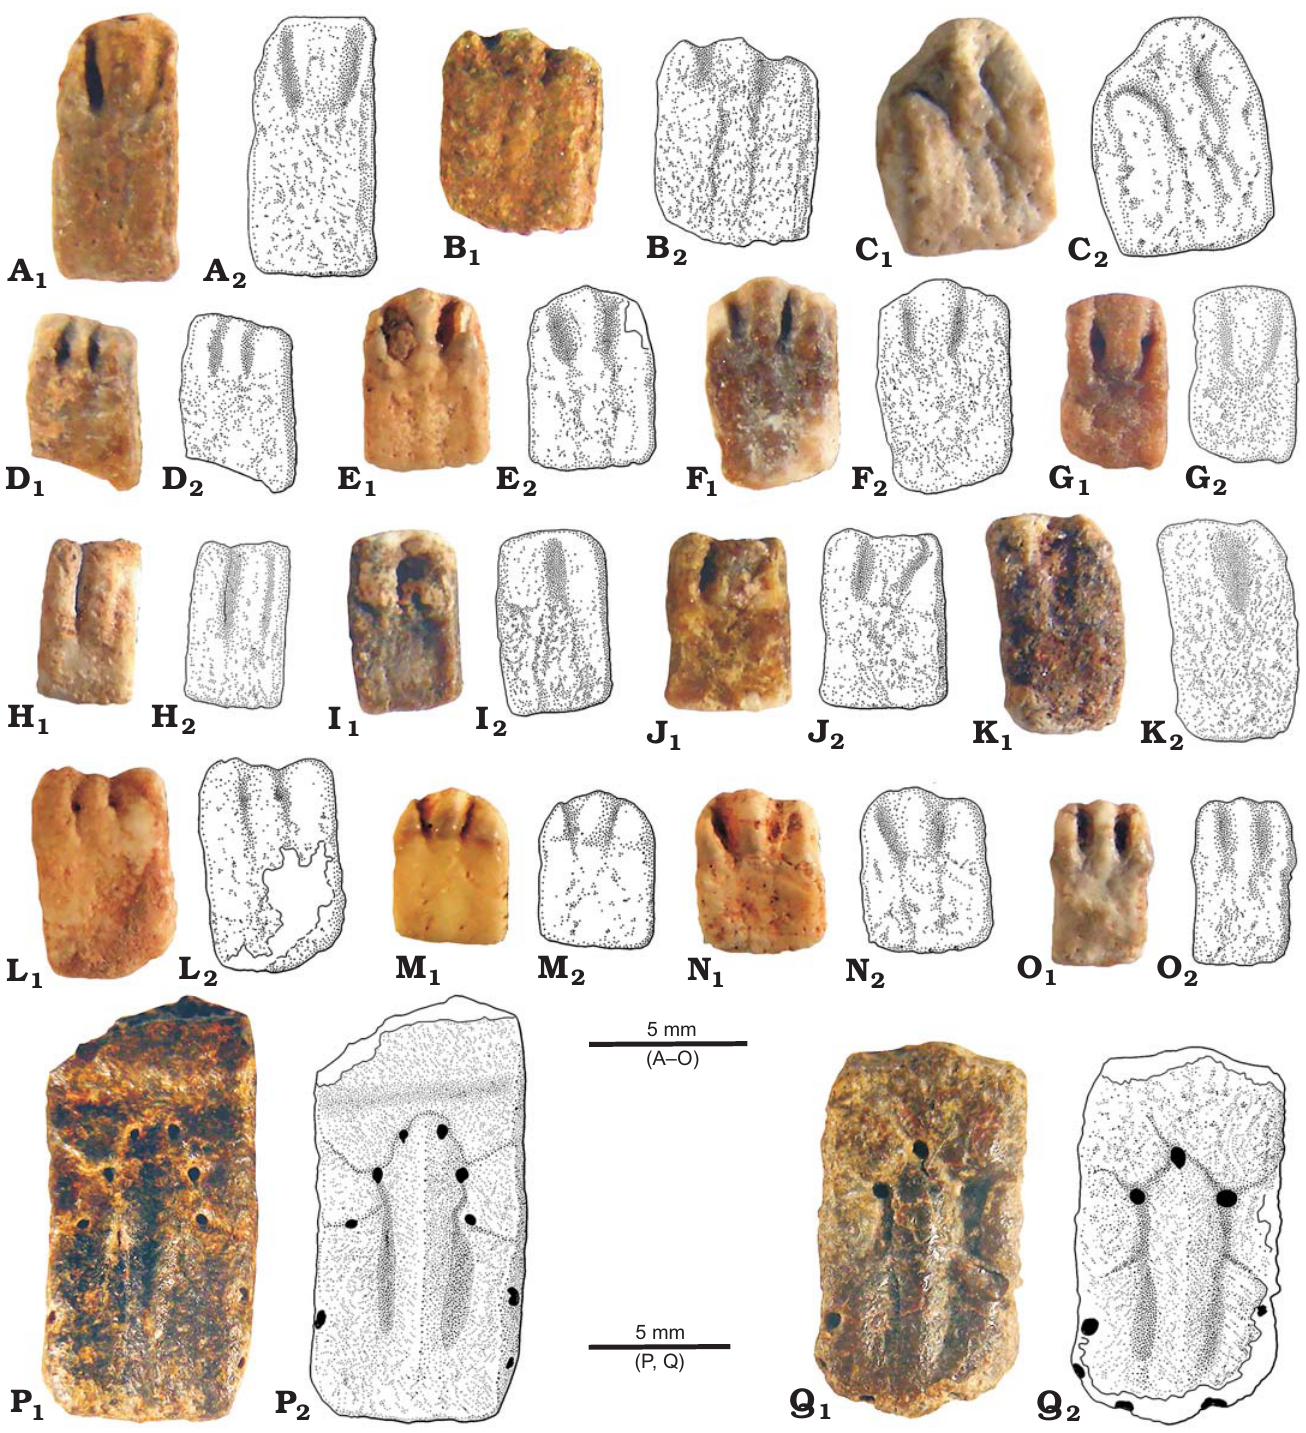
Fig. 6. Osteoderms of Dasypodidae incertae sedis from the middle member of the Geste Formation, middle–late Eocene, Antofagasta de la Sierra, Catamarca Province, Argentina. A–O . Pucatherium parvum MLP 93-VI-1-17 ( A–F ), MLP 88-V-10-19 ( G–O ). P , Q . Punatherium catamarquensis gen. et sp. nov., holotype, fixed osteoderm, MLP 93-VI-1-18 ( P ) and paratype, semimovable osteoderm, MLP 86-V-6-24 ( Q ). Photographs (A 1 − Q 1 ), line drawings (A 2 − Q 2